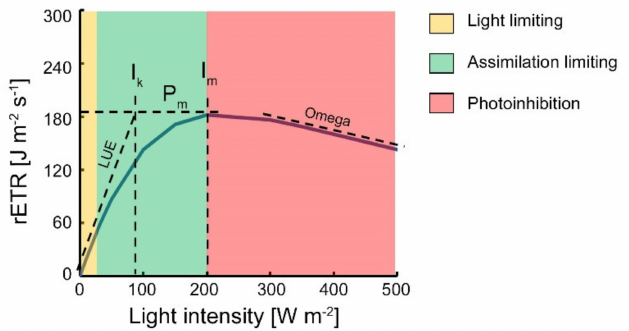
Figure 1. Light response curve and its parameterization. rETR refers to relative Electron Transport Rate, LUE—light use e ffi ciency, P m —maximum rETR, I k —characteristic intensity, I m —maximum intensity, Omega—stress reaction magnitude. Color code: Light limiting intensity range, carbon assimilation limiting intensity range and photoinhibition limiting intensity range are yellow, green and red colors,